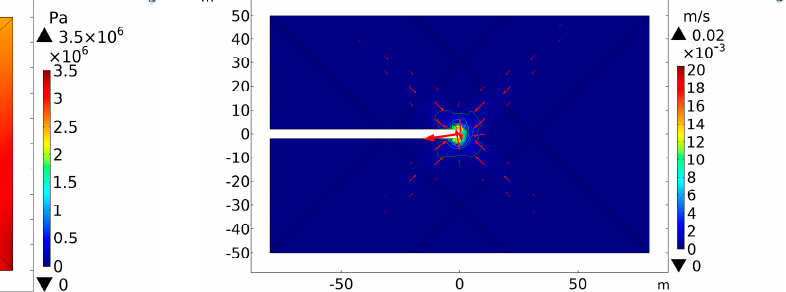
( b ) FV contour and vector diagram on XZ Y=0 section